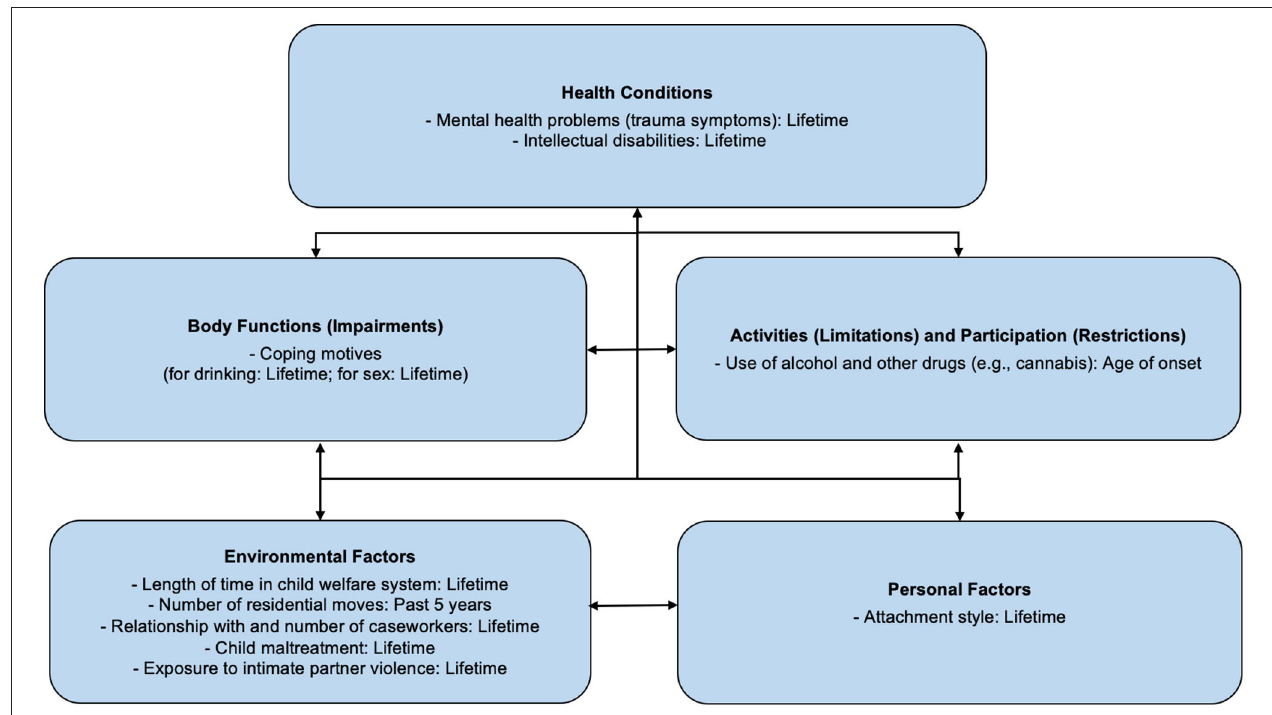
FIGURE 2 | Proximal ICF factors: Coping motives refer to the process governing the choices made towards various coping behaviours, in an effort to manage stress ( 73). Maladaptive coping motives may lead to health-risk behaviours (e.g., drinking alcohol to cope with negative affect) (74).